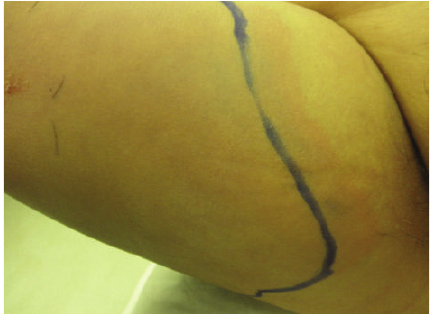
Figure 2: Photograph showing line of demarcation of erythema after admission and subsequent rapid progression of erythema within 1 hour. The rapid spread of necrotizing infection is facilitated by the enzymes and toxins produced by the organisms and is one of the hallmarks for clinical diagnosis.